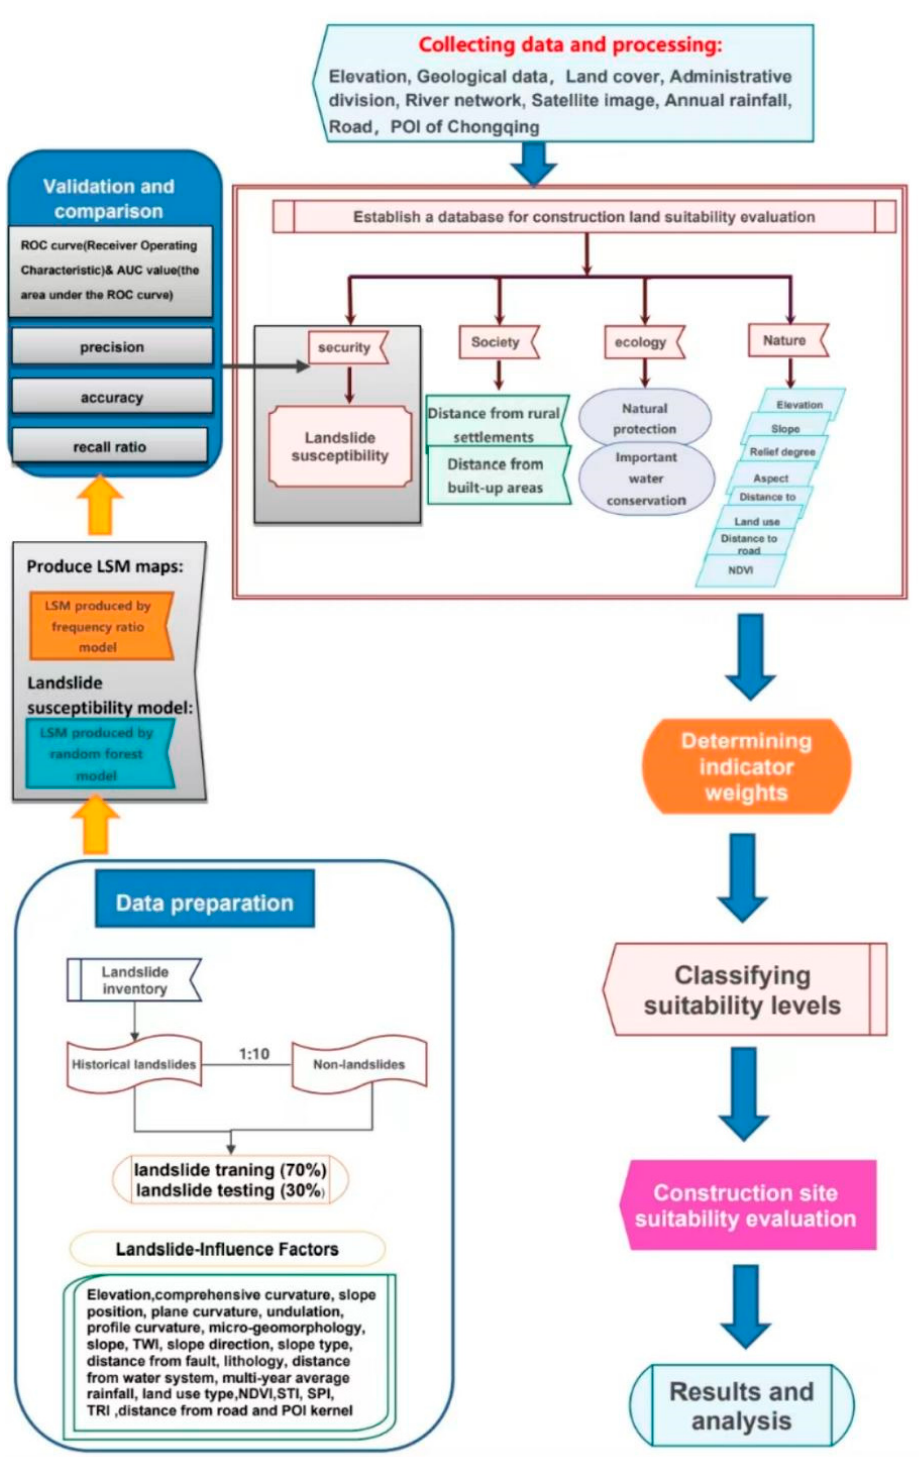
Figure 2. Flow chart of the study.